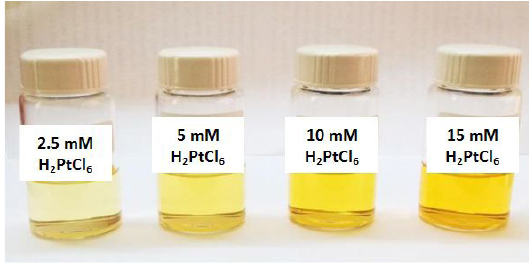
PtCl in absolute ethanol. 2 6